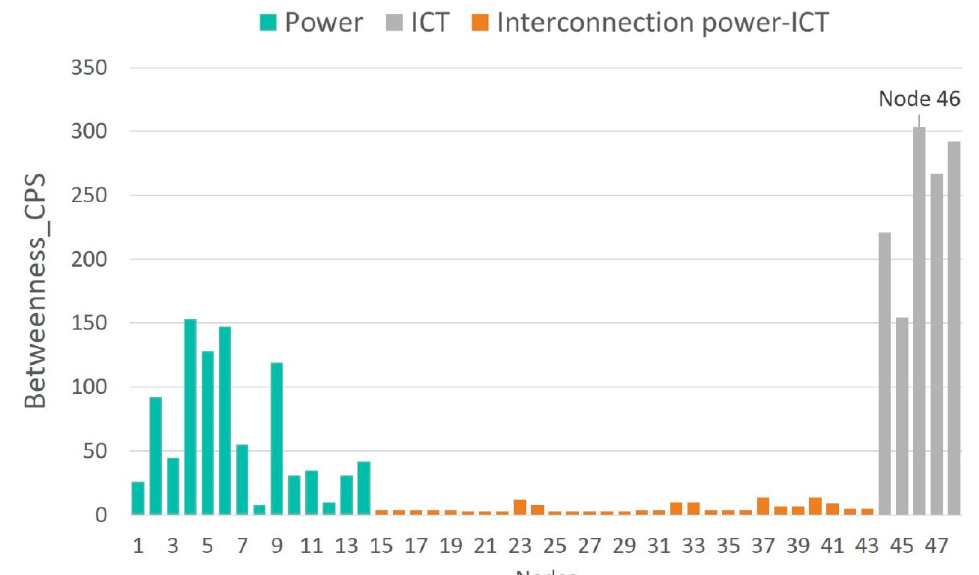
Figure 7. Betweenness vulnerability values of the cyber-physical IEEE 14-bus test case.